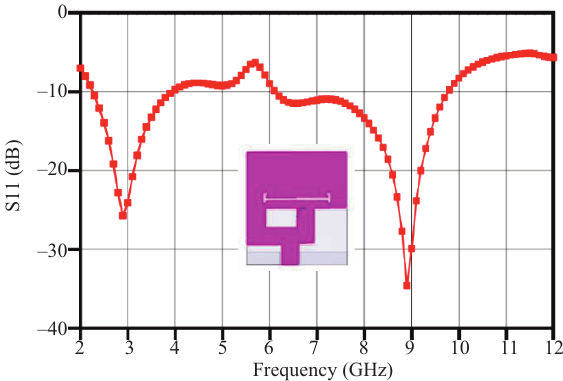
Fig. 4. Simulated S11 response with one H­shaped slot etched on the top of the radiating patch.